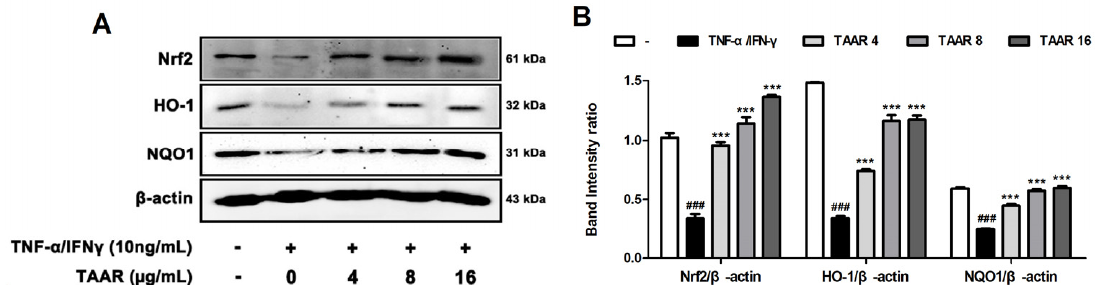
Figure 4. Effects of TAAR extract on the NF κ B and MAPK signaling pathways in TNF- α /IFN- γ - induced HaCaT cells. ( A ) Protein levels of cytosol I κ B and nucleus NF κ B. ( B ) Bar graph showing the relative density of the Western blot band pI κ B/ β -actin and NF κ B/lamin B. ( C ) Protein expression levels of phosphorylated and total MAPKs (p38, ERK, and JNK). ( D ) Bar graph showing the relative density of the Western blot band pp38/p38, pERK/ERK, and pJNK/JNK. All values are presented as the mean ± SEM of three experiments. Data were analyzed by Tukey’s post hoc test. ### p < 0.001 vs. no treatment group; * p < 0.05, ** p < 0.01, and *** p < 0.001 vs. TNF- α /IFN- γ treatment only group.